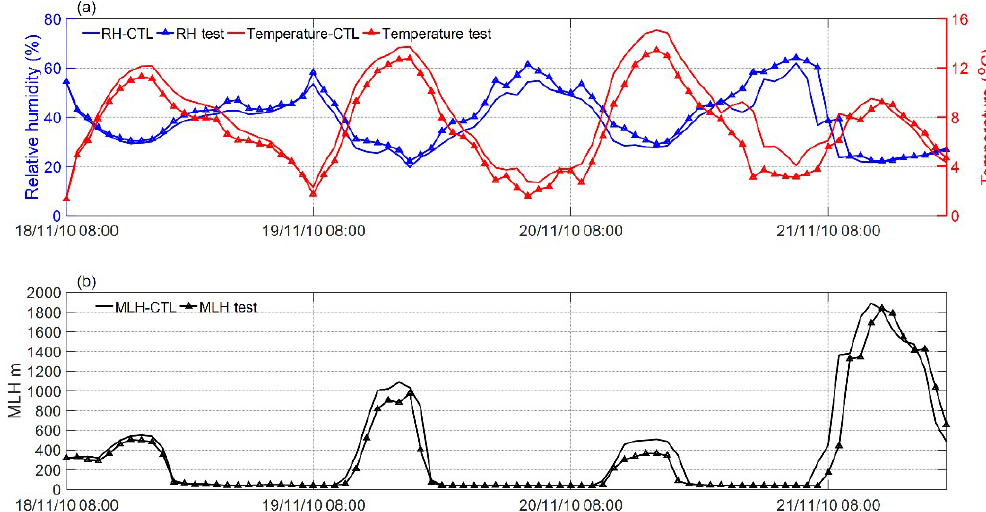
Figure 3. (a) Modelled variation of surface relative humidity and temperature and (b) mixing layer height during the intensive haze episode from 18 to 21 November 2010. The lines with triangles on them represent results from the test experiment, while the lines without triangles represent results from the control experiment. The control experiment was performed with the absence of aerosol direct radiative forcing in the RRTMG radiation scheme, while the test experiment was conducted with the presence of aerosol direct radiative forcing